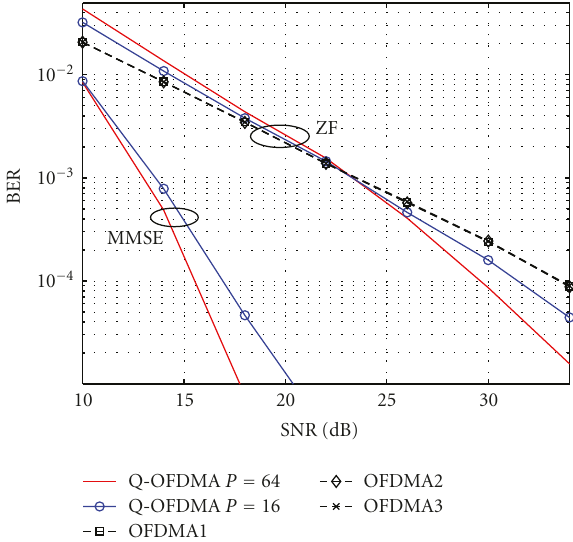
Figure 5: BER of uncoded systems with BPSK modulation under CM2 channel model, where N =